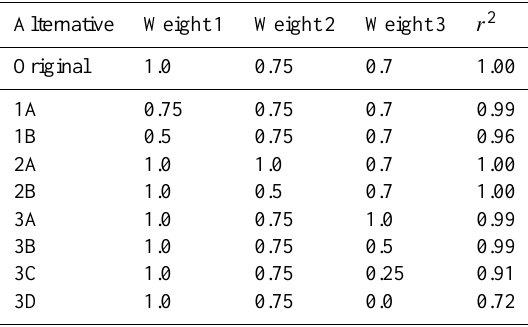
Table 5. Results from the sensitivity analysis: The weights for the vulnerability indicators and the resulting correlation coefficient r 2 with the vulnerability scores applying the original set of